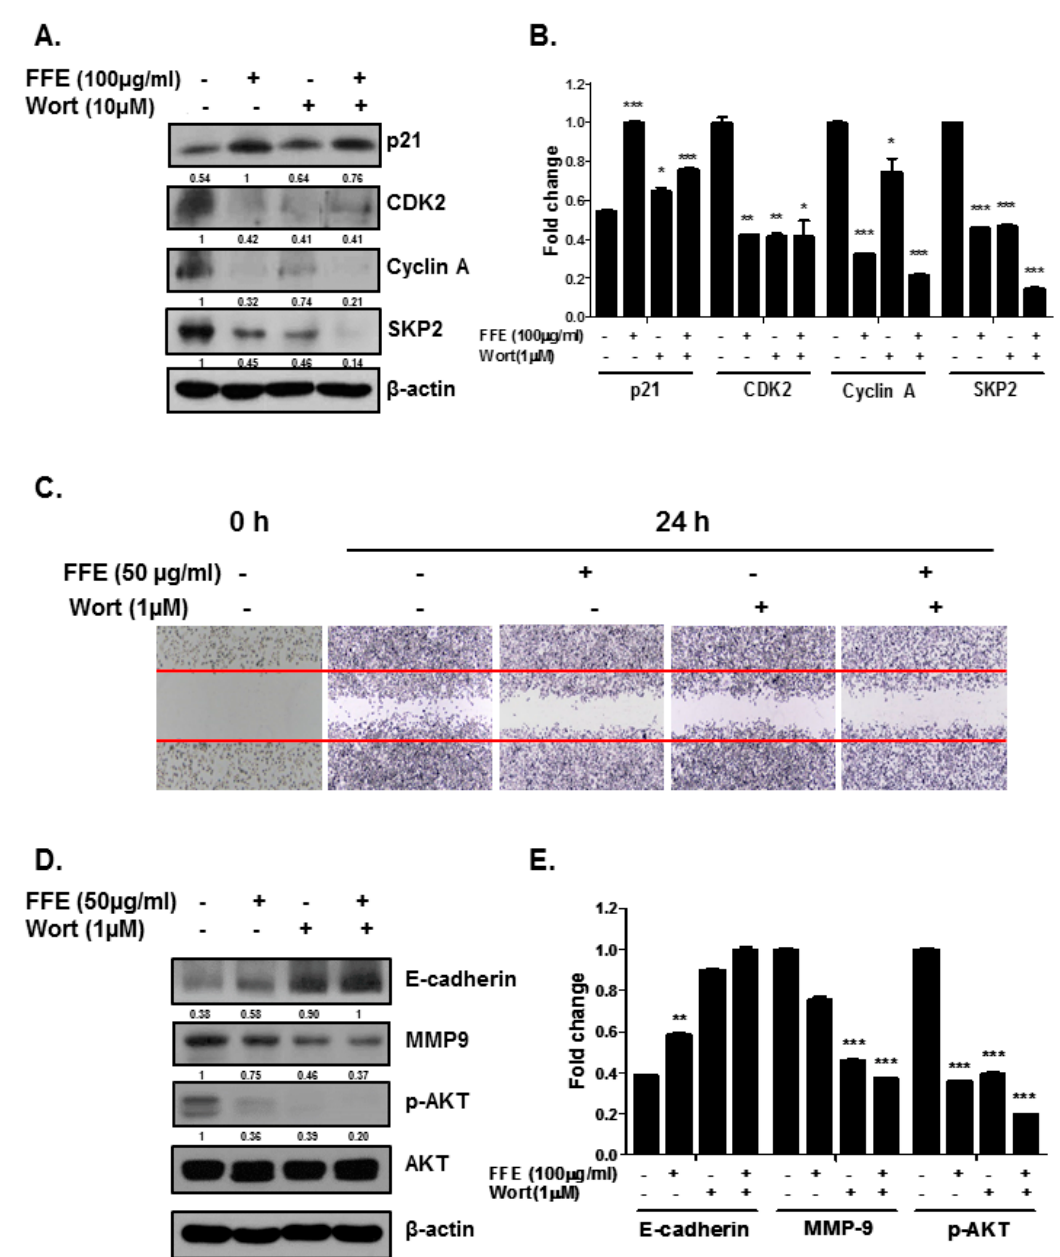
Figure 5. Effects of AKT inhibitor wortmannin (Wort) on migration, cell cycle, and migration related makers in FFE treated MDA-MB-231 cells. Cells treated with FFE for 24 h after 1 hour pretreatment with Wort. ( A ) Cell lysates prepared and subjected to Western blotting with antibodies against p21, CDK2, Cyclin A, SKP2 and β -actin. ( B ) Fold change of Western blot. Data represent mean ± SD, * p < 0.05, ** p < 0.01 and *** p < 0.001 compared with control. ( C ) Cell migration assayed by wound healing assay. The number of cells migrating into the scratched area photographed ( × 100). ( D ) Cell lysates prepared and subjected to Western blotting with antibodies against E-cadherin, MMP-9, p-AKT, AKT and β -actin. ( E ) Fold change of Western blot. Data represent mean ± SD, * p < 0.05, ** p < 0.01 and *** p < 0.001 compared with control.